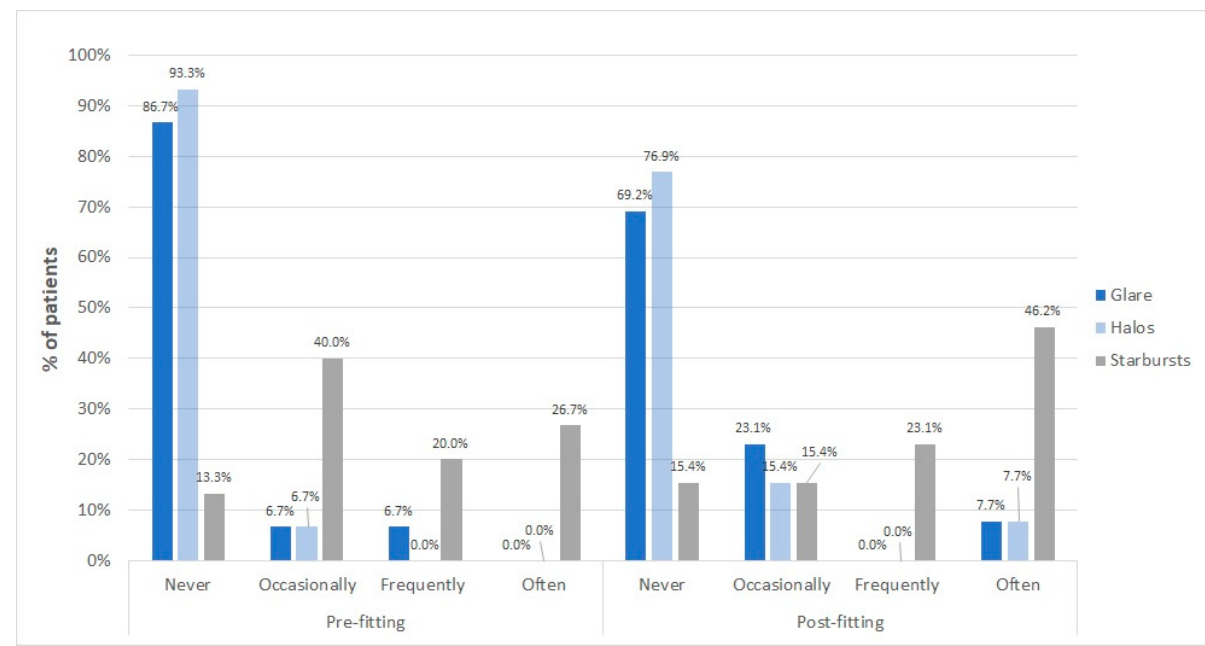
Figure 3. Distribution of the frequency of perception of glare, halos and starbursts before (with 15 patients) and after 30 days of CL wear (with 13 patients) in the sample evaluated.